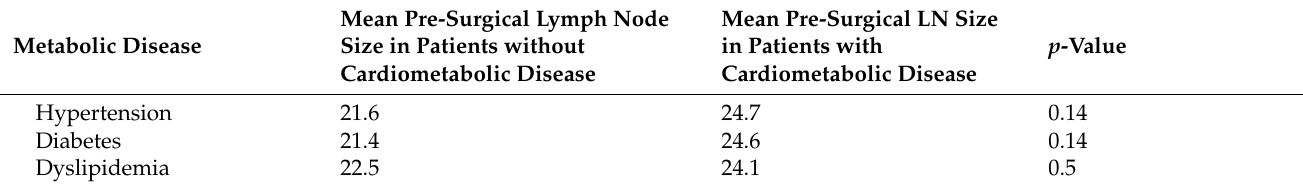
Table 2. Mean pre-surgical lymph node size in patients with and without cardiometabolic dis- ease. Mean pre-surgical lymph node size in millimeters was compared between individuals with and without hypertension, diabetes, dyslipidemia, or any combination of metabolic disease prior to surgery.